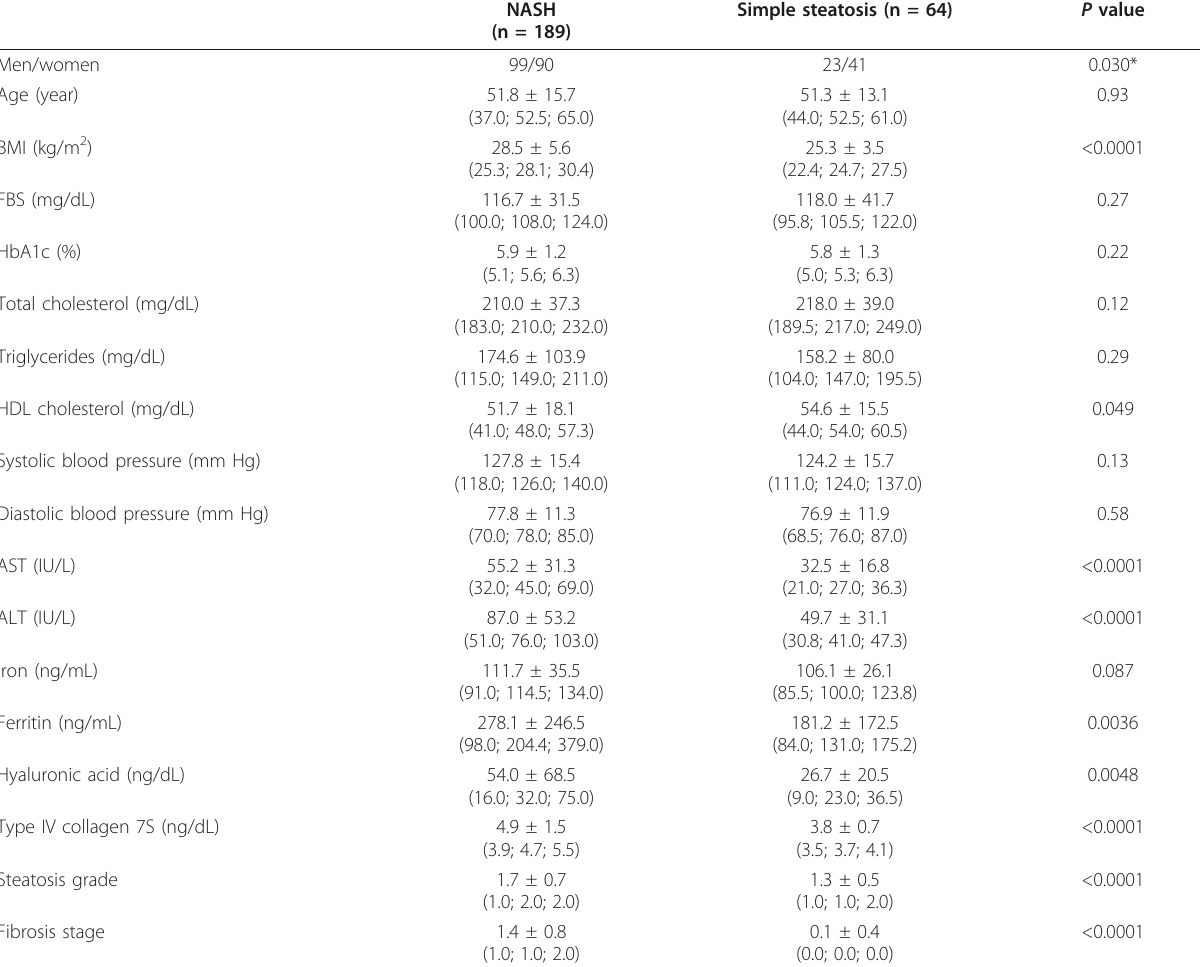
Table 2 Clinical characteristics of patients with NASH and simple